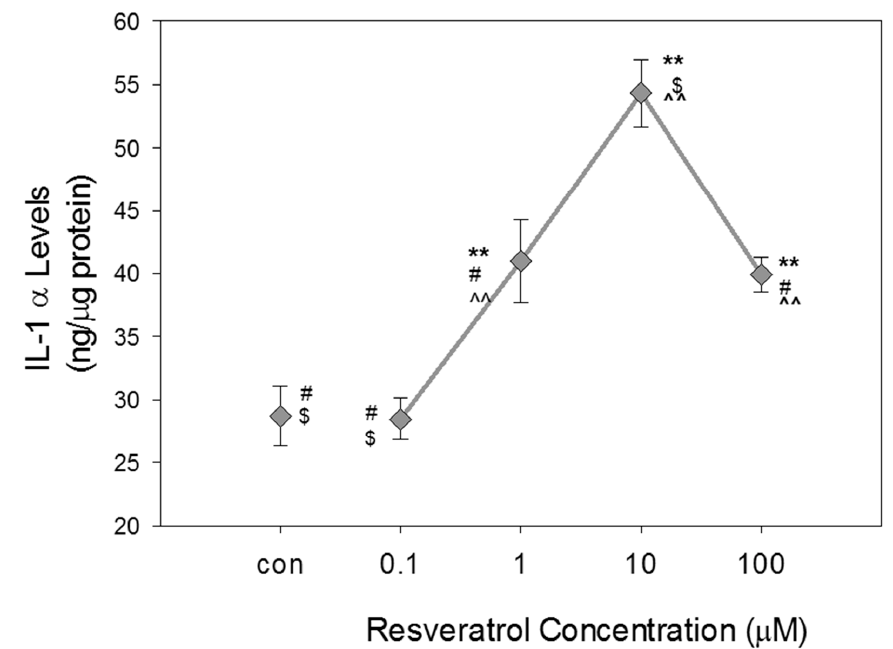
Figure 6. Effects of resveratrol on IL-1 α levels in GTM-3 cells following 24-h exposure. Figure shows mean ± SEM ( n = 3). ** = p < 0.05 compared to control, ^^ = p < 0.05 compared to 0.1 µM, $ = p < 0.05 compared to 1 µM, # = p < 0.05 compared to 10 µM. con — control.